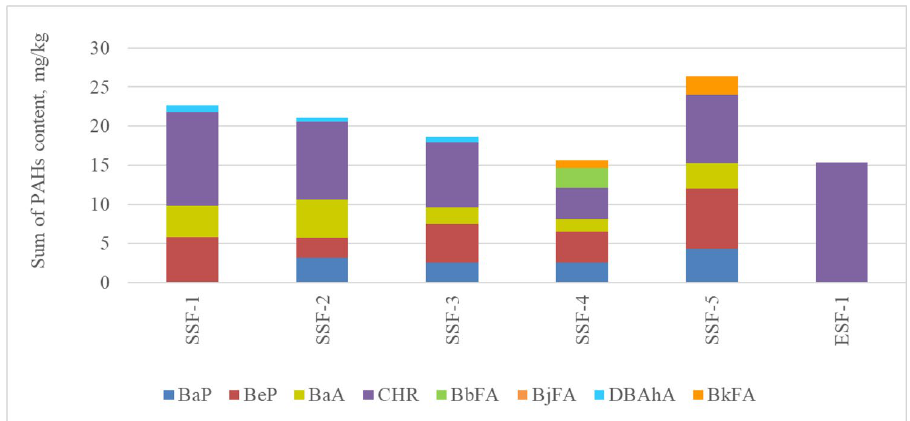
Figure 4. The sum of the PAHs content in the tested rubber granulate samples taken from the sport fields. SSF a sample of SBR granules from a sport field, ESF a sample of EPDM granules from a sport field.